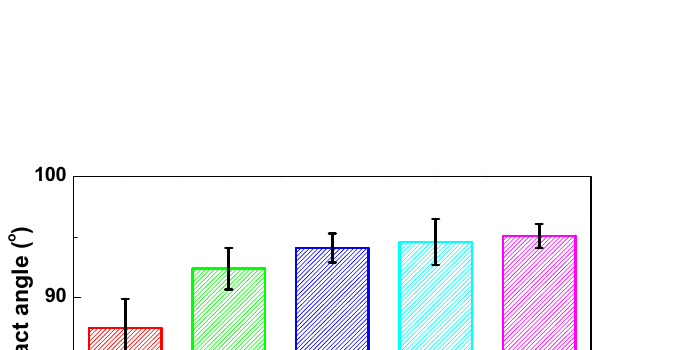
Figure 7. SEM images of surface morphologies and corresponding EDS mappings of C, N, Si of coatings, PU/2 wt% POSS-BEN nanocomposite PCU/BEN2 ( a ) and PU/2 wt% POSS-PEG nanocomposite (PCU/PEG2) ( b ) at × 1000 magnification, and EDS spectra of PCU/BEN2 ( c ) and PCU/PEG2 ( d ).